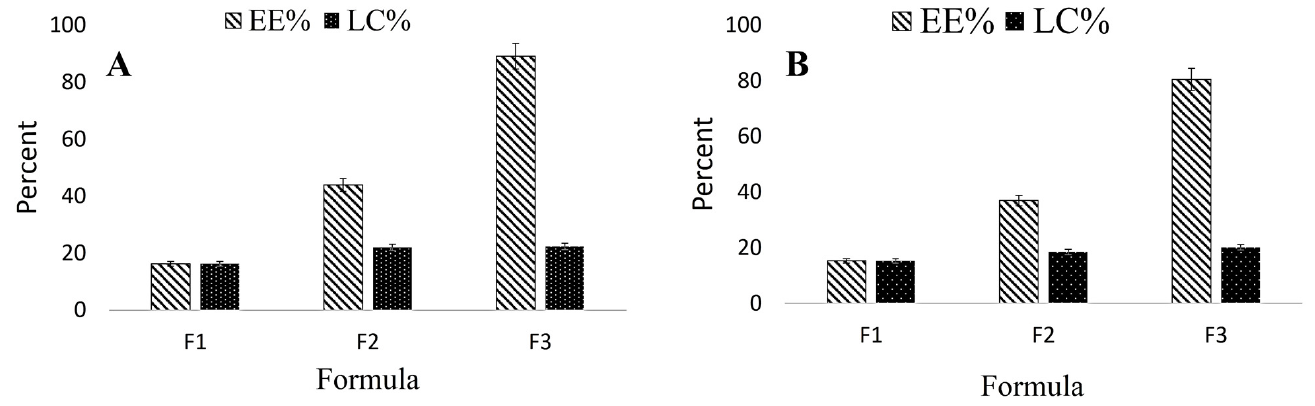
Figure 1. EE% and LC% of GM ( A ) and AA ( B ) in GM–AA–CSNPs. CS:GM:AA ratio F1 (1:1:1)–F2 (2:1:1)–F3 (4:1:1).